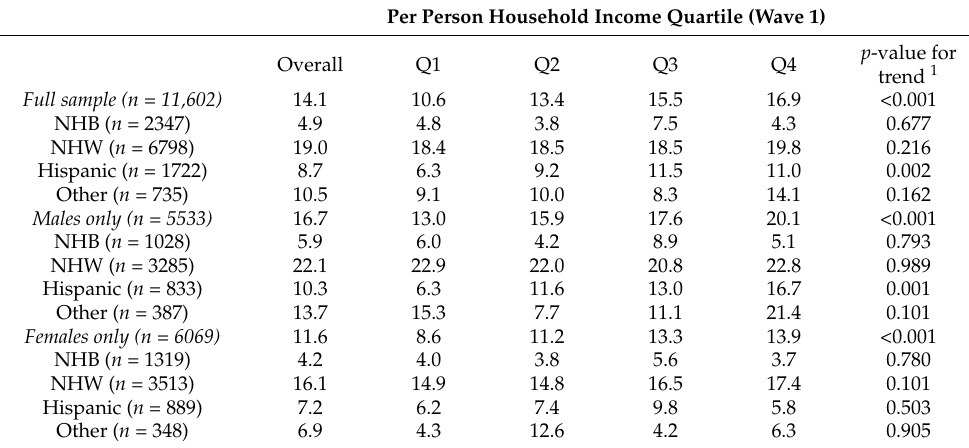
Table 2. Crude prevalence (%) of reported NMUPP at Wave 4 ( n = 11,602).